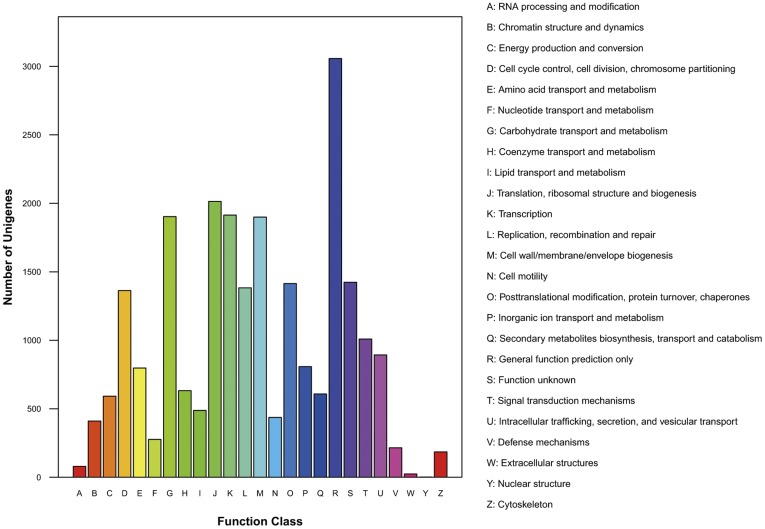
Histogram presentation of clusters of orthologous groups (COG) classification.A total of 9,650 sequences have a COG classification among the 25 categories.